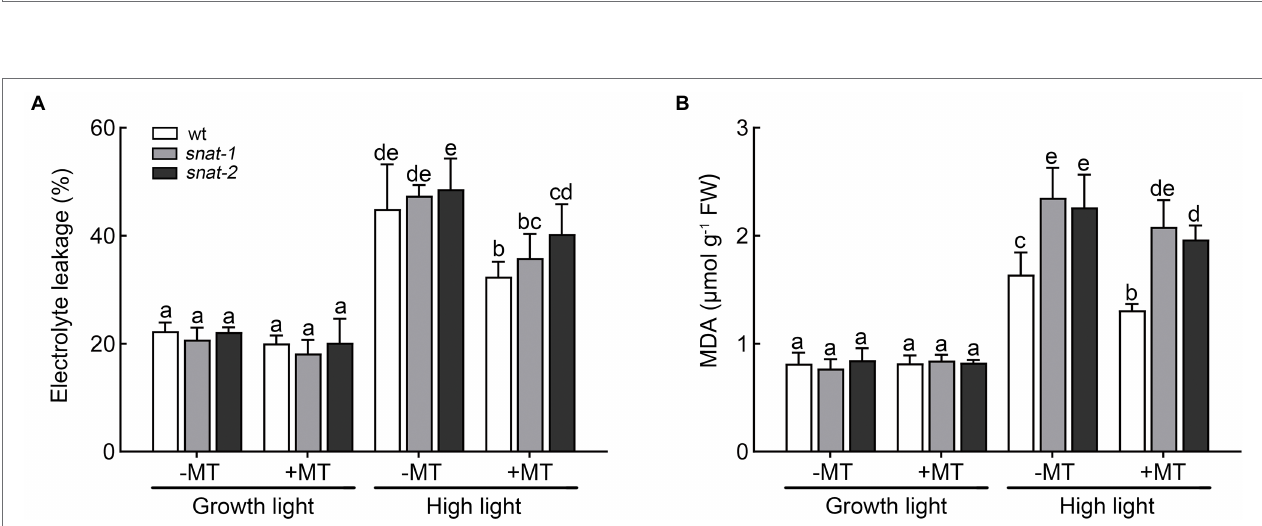
FIGURE 4 | Effects of exogenous melatonin on reactive oxygen species. (A) Accumulation of hydrogen peroxide (H 2 O 2 ) was visualized by 3,3 ′ -diaminobenzidine (DAB) staining. (B) The content of hydrogen peroxide (H 2 O 2 ). (C) Accumulation of superoxide anion radicals ( − O 2 ) was visualized by nitrotetrazolium blue (NBT) staining. (D) The content of superoxide anion radicals ( − O 2 ).